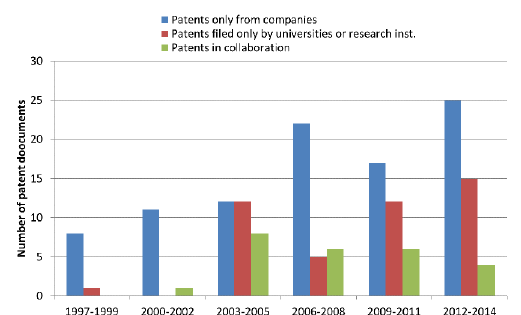
Figure 2. Categories of main patent holders on amorphous alloys processed by thermal spraying processes between the years of 1997 and 2014. Source: Derwent Innovations Index.